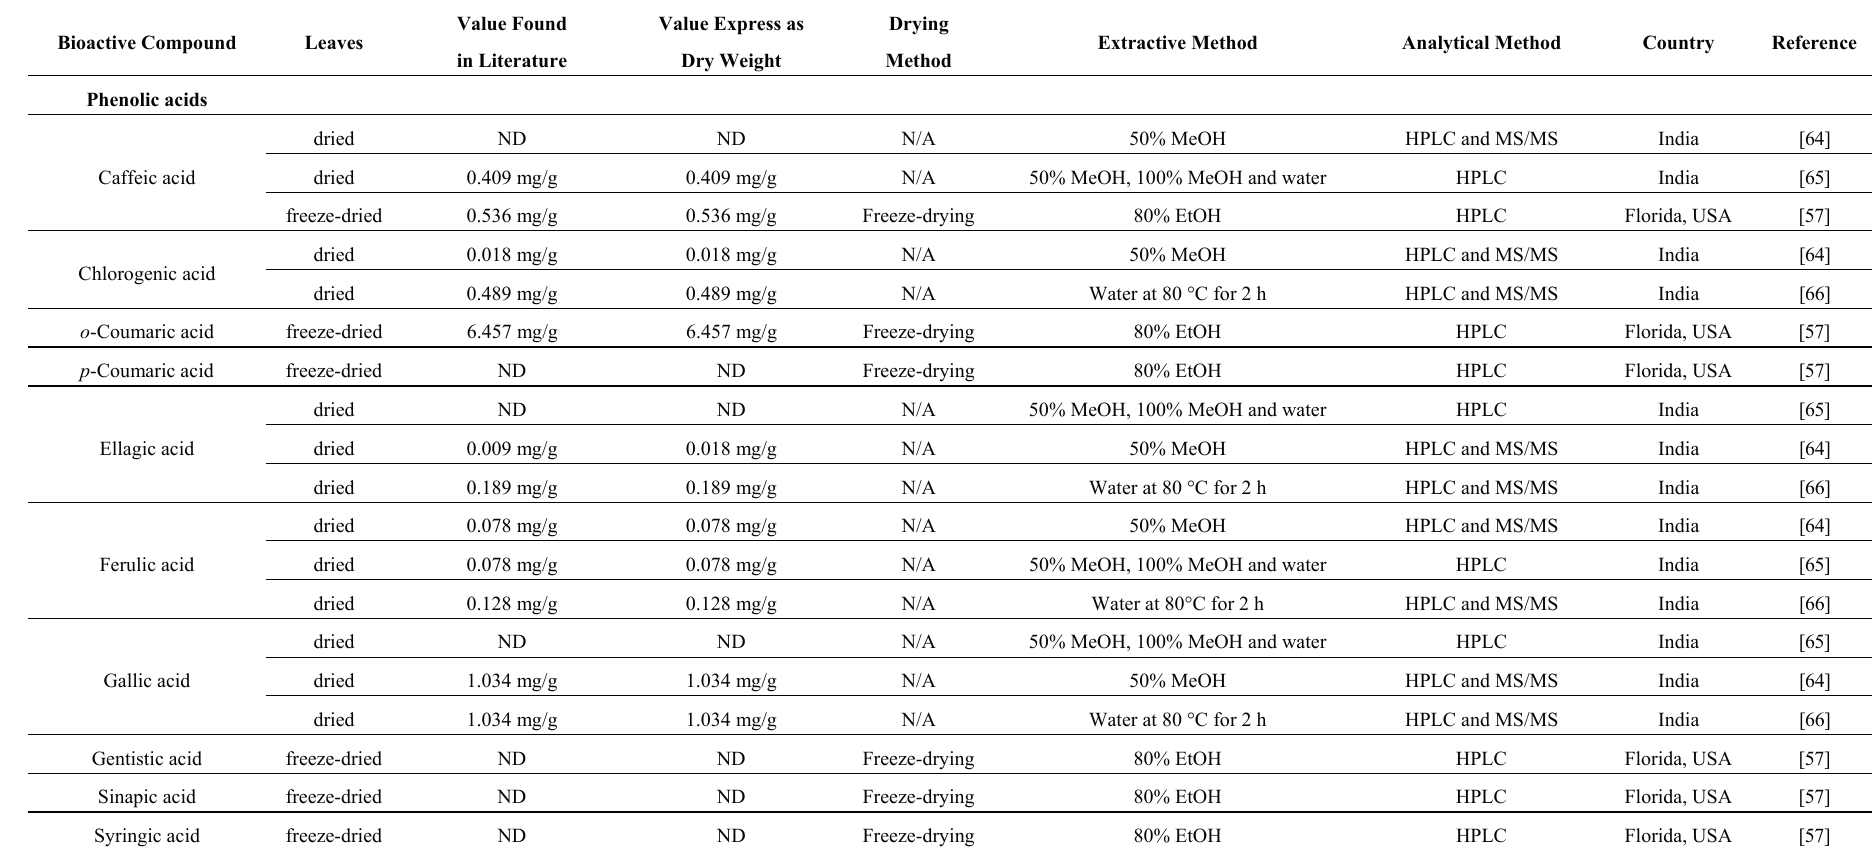
Abbreviations: ND = Not detected; N/A = Not